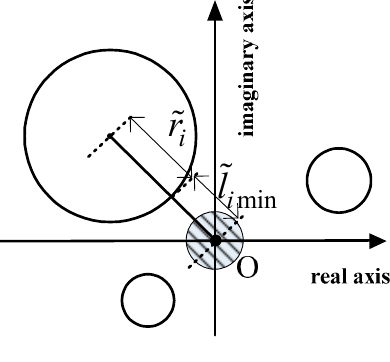
Figure 4. Schematic of Formula (13).